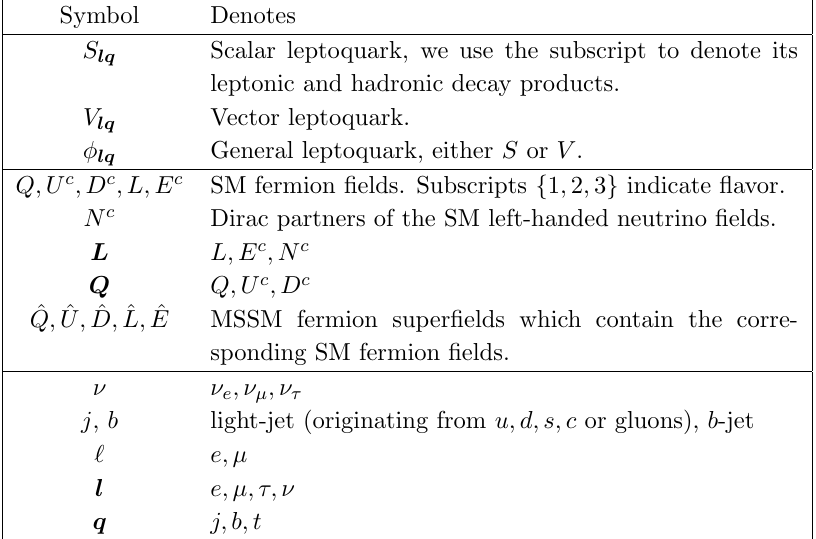
Table 12 . Summary of